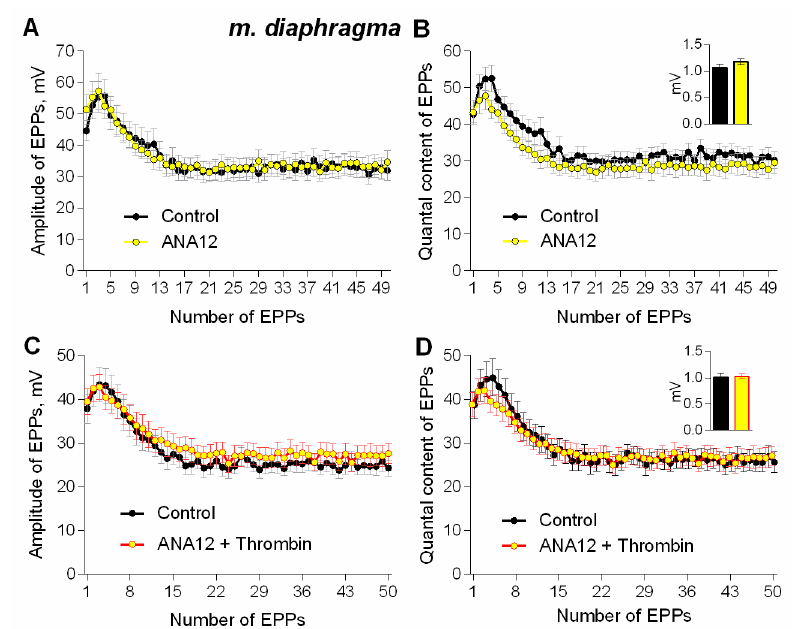
Figure 5. TrkB receptors mediate thrombin-induced upregulation of evoked neuromuscular transmission during short (1 s) high-frequency (50 Hz) trains at NMJs in mouse diaphragm. ( A ) Changes in the EPP amplitude in control ( n = 17) and upon application of TrkB receptor antagonist ANA12 (10 µM) ( n = 24). ( B ) Quantal content of EPPs in control and upon application of ANA12. ( C ) Changes in the EPP amplitude in control ( n = 17) and upon application of thrombin (1 nM) ( n = 16) in the presence of ANA12 ( n = 23). ( D ) Quantal content of EPPs in control and upon application of thrombin in the presence of ANA12. Histograms, symbols and error bars represent the mean ± SEM. The insets show MEPP amplitudes.